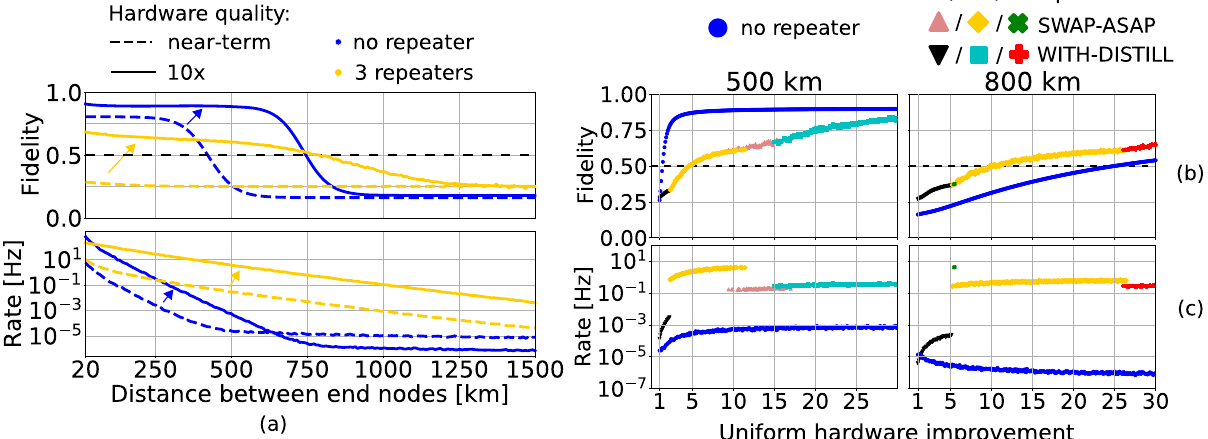
Fig. 5 Performance of repeaters based on nitrogen-vacancy (NV) centres in diamond. a Fidelity and entanglement distribution rate achieved with near- term and 10× improved hardware (Supplementary Note 4) with the SWAP-ASAP protocol. Dashed line represents classical fi delity threshold of 0.5. We observe that for near-term hardware, the use of three repeaters yields worse performance in terms of fi delity than the no-repeater setup. For improved hardware we observe (i) that for ~0 – 750 km, repeaters improve upon rate by orders of magnitude while still producing entanglement ( fi delity > 0.5), while (ii) for ~750 – 1500 km, repeaters outperform in both rate and fi delity. b , c Fidelity and rate achieved without and with repeaters (1, 3 or 7 repeaters) as function of a hardware improvement factor (Methods, section ‘ How we choose improved hardware parameters ’ ) for two typical distances from both distance regime (i) and (ii), for two protocols SWAP-ASAP and NESTED-WITH-DISTILL. For the repeater case, only the best-performing number-of- repeaters and protocol in terms of achieved fi delity is shown in ( b ), accompanied by its rate in ( c ). Each data point represents the average over ( a ) 200 and ( b ) 100 runs. Standard deviation is smaller than dot